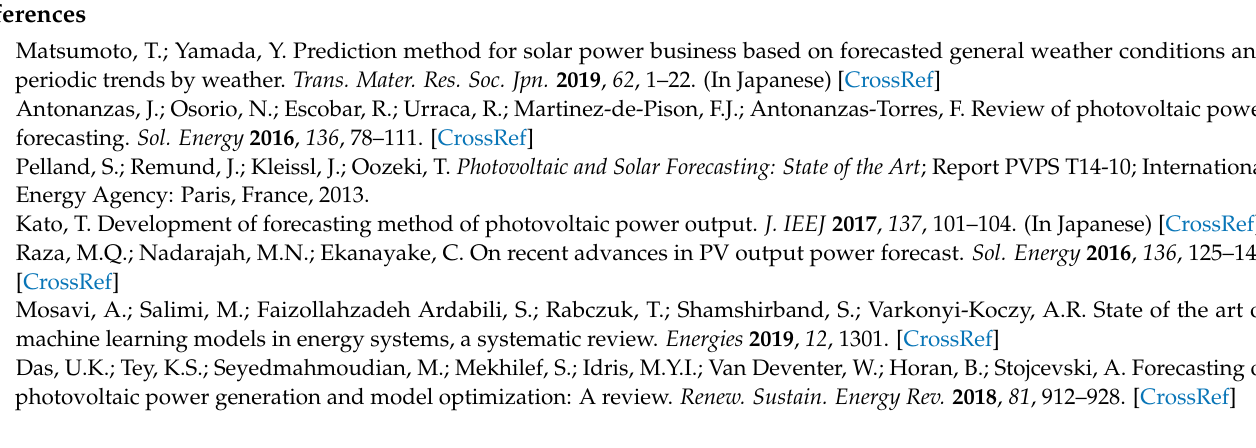
Figure A2. Trend estimation results for the M3 model (estimated from 9 months of in-sample data). Note: The units of vertical axis and “Radiation” axis are (MW) and (MJ/m 2 ), respectively. “Seasonal” denotes a yearly cyclical dummy variable (see Section